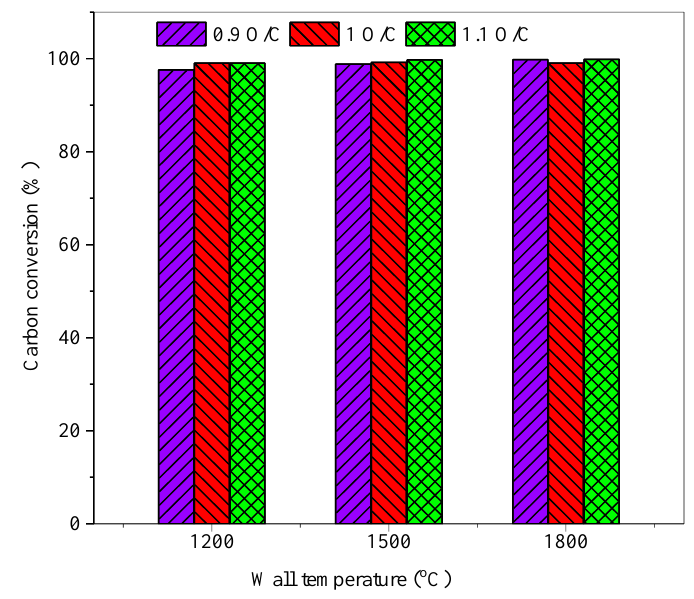
Figure 9. Carbon conversion for various cases.